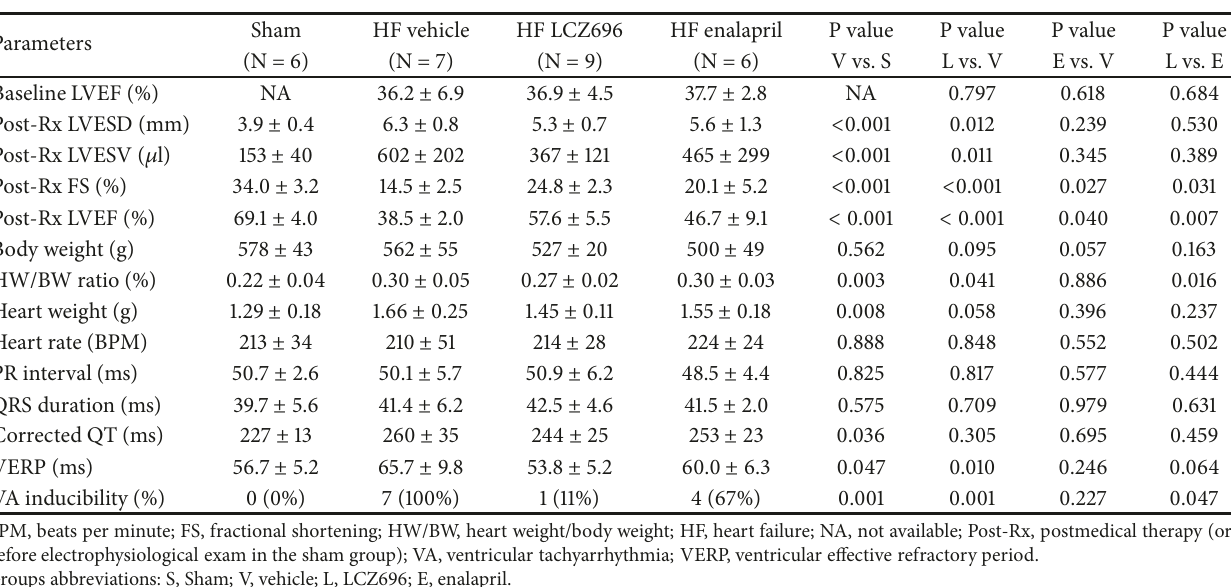
Table 1: Echocardiographic, electrophysiological, and anatomic parameters.